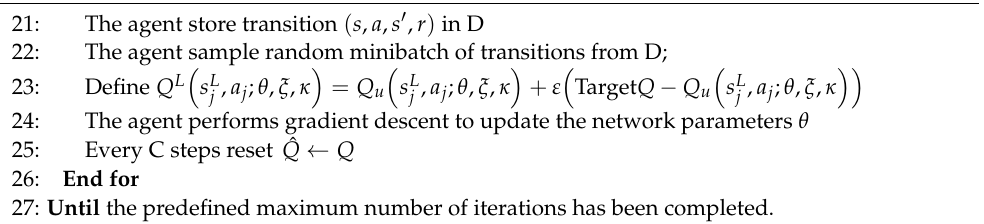
Algorithm 1 The network slicing resource allocation based on LSTM-D3QN with DC.